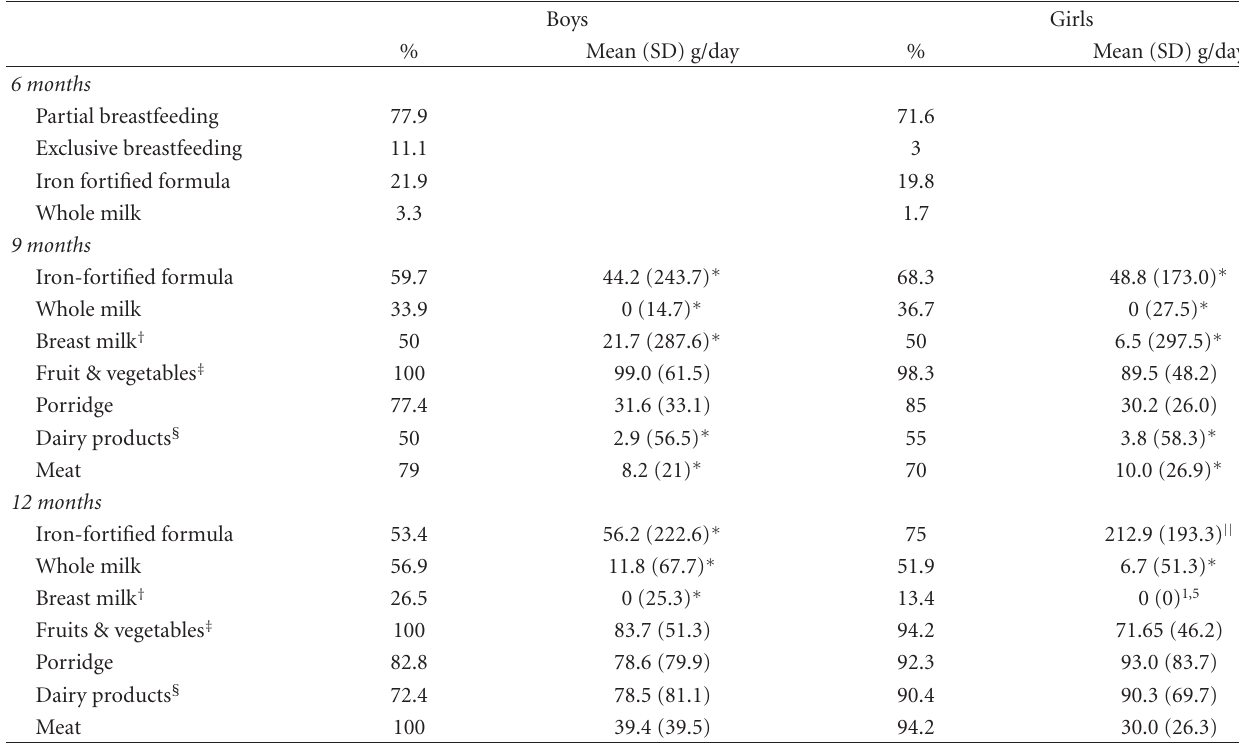
Table 2: Intake of selected foods among boys and girls at 6, 9, and 12 months of age ( n = 141 at 6 months, n = 122 at 9 months, and n = 110 at 12